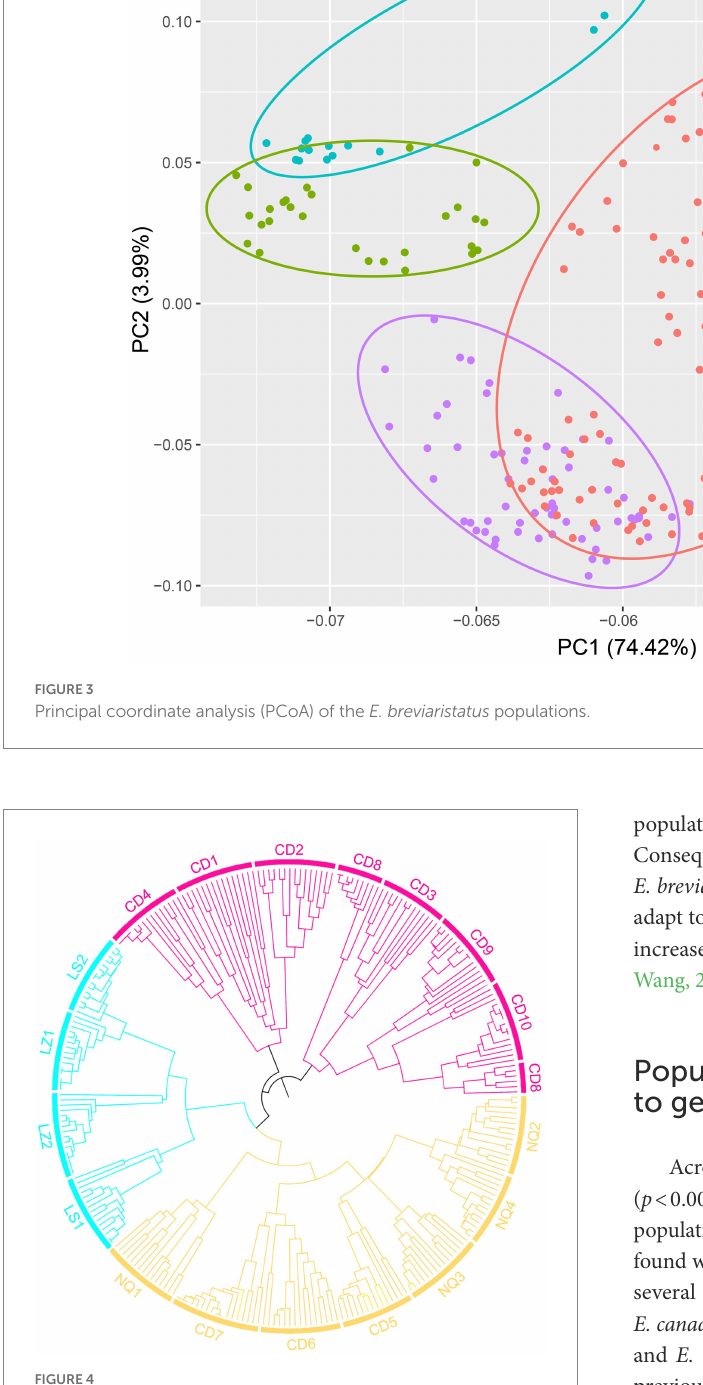
FIGURE 4 UPGMA dendrogram based on individual pairwise Nei’s genetic distances showing relationships among individuals of E.